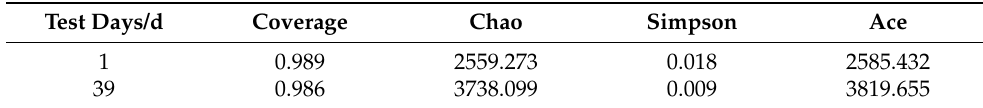
Figure 5. Changes in SCOD during the initiation of partial nitrosation process. Table 2. Microbial community richness and diversity index. Table 2. Microbial community richness and diversity index.